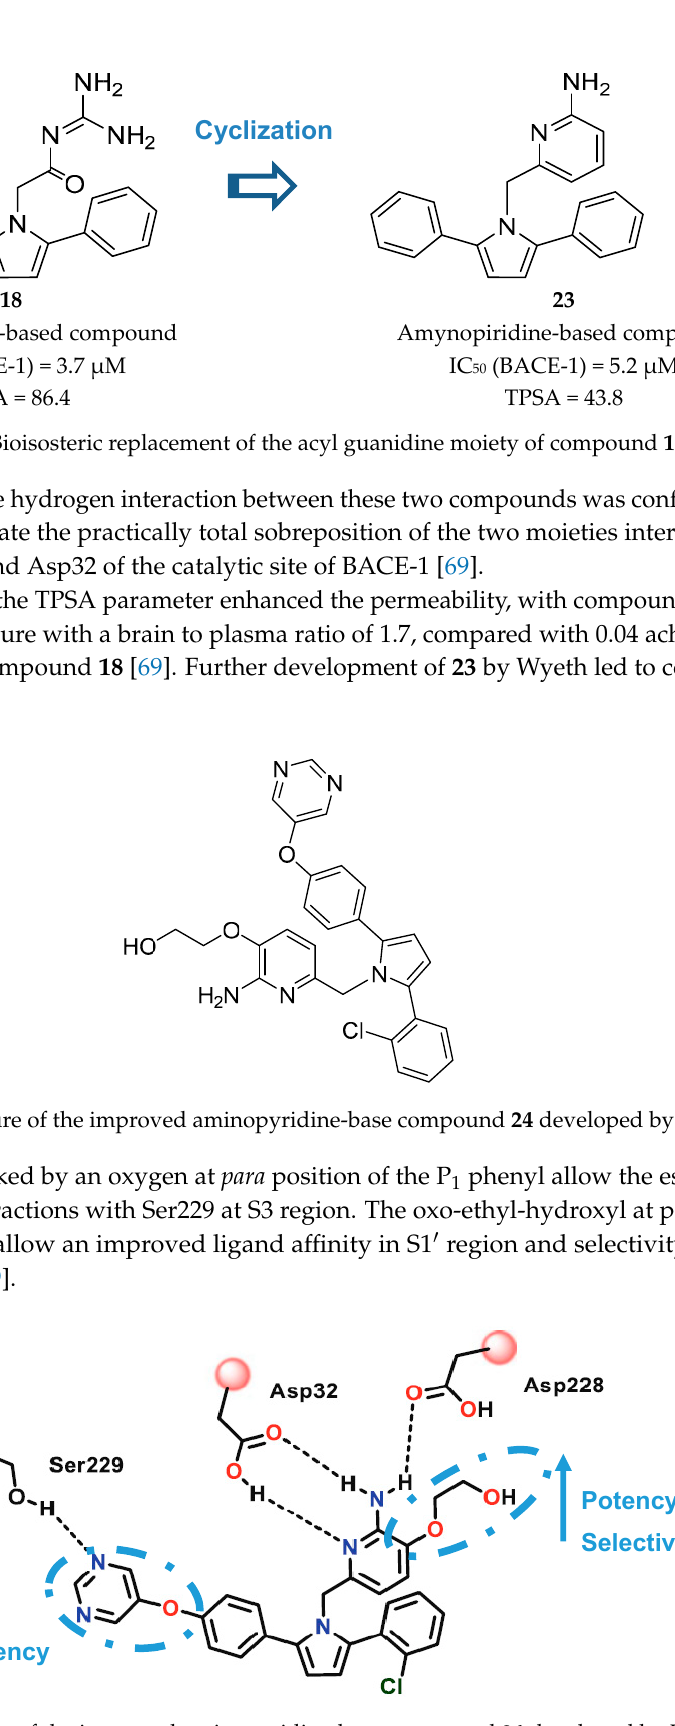
Figure 22 . Interactions of the improved aminopyridine-base compound 24 developed by Wyeth with the catalytic site of BACE-1. Adapted from [16].